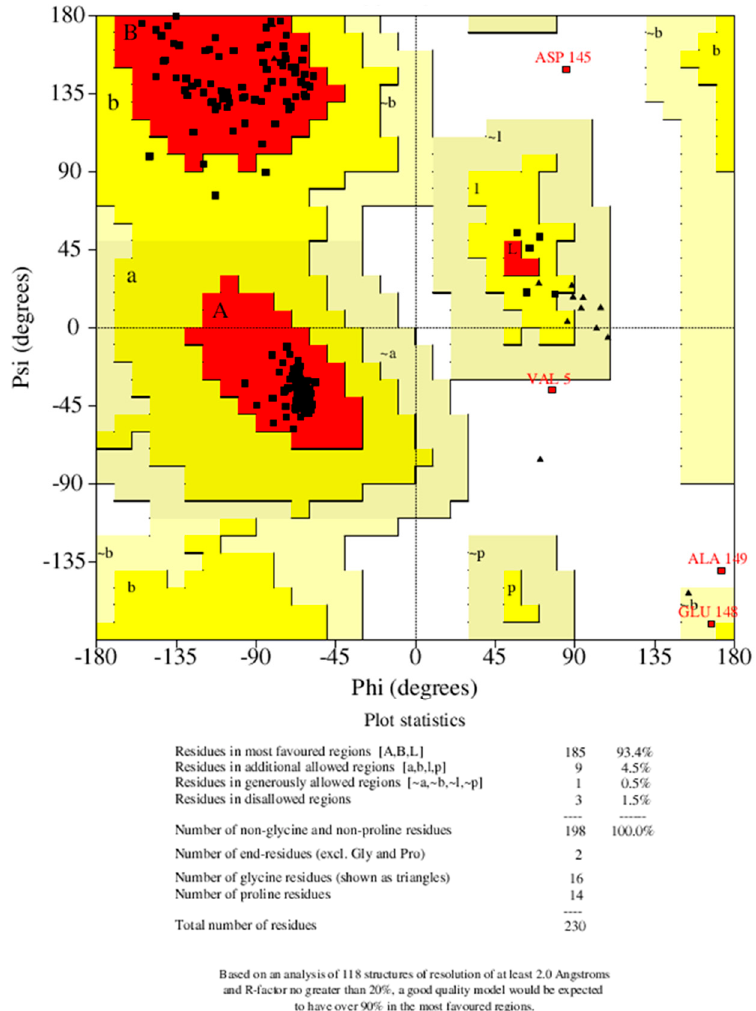
Figure 2. Ramachandran plot of ideR. This plot gives a general overview of the quality of the protein ( > 90%) fall within the favored structure. The selected model is seen to have a reasonably good quality since most of its residues (>90%) fall within the favored region.